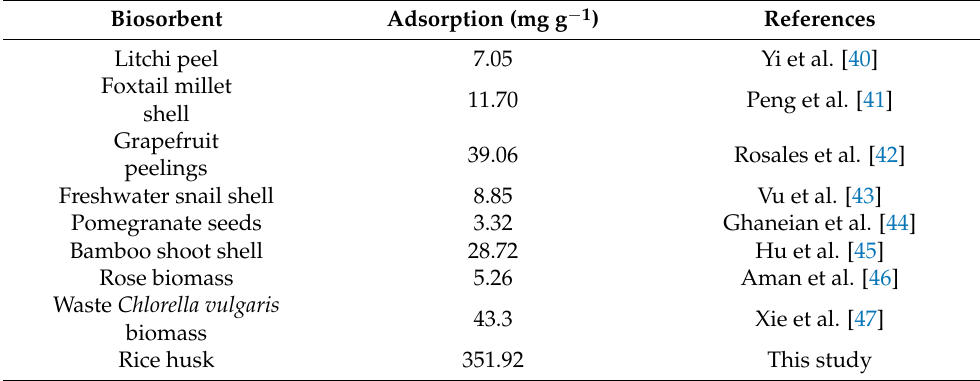
Table 3. Comparison of various biosorbents with rice husk for Cr(VI)